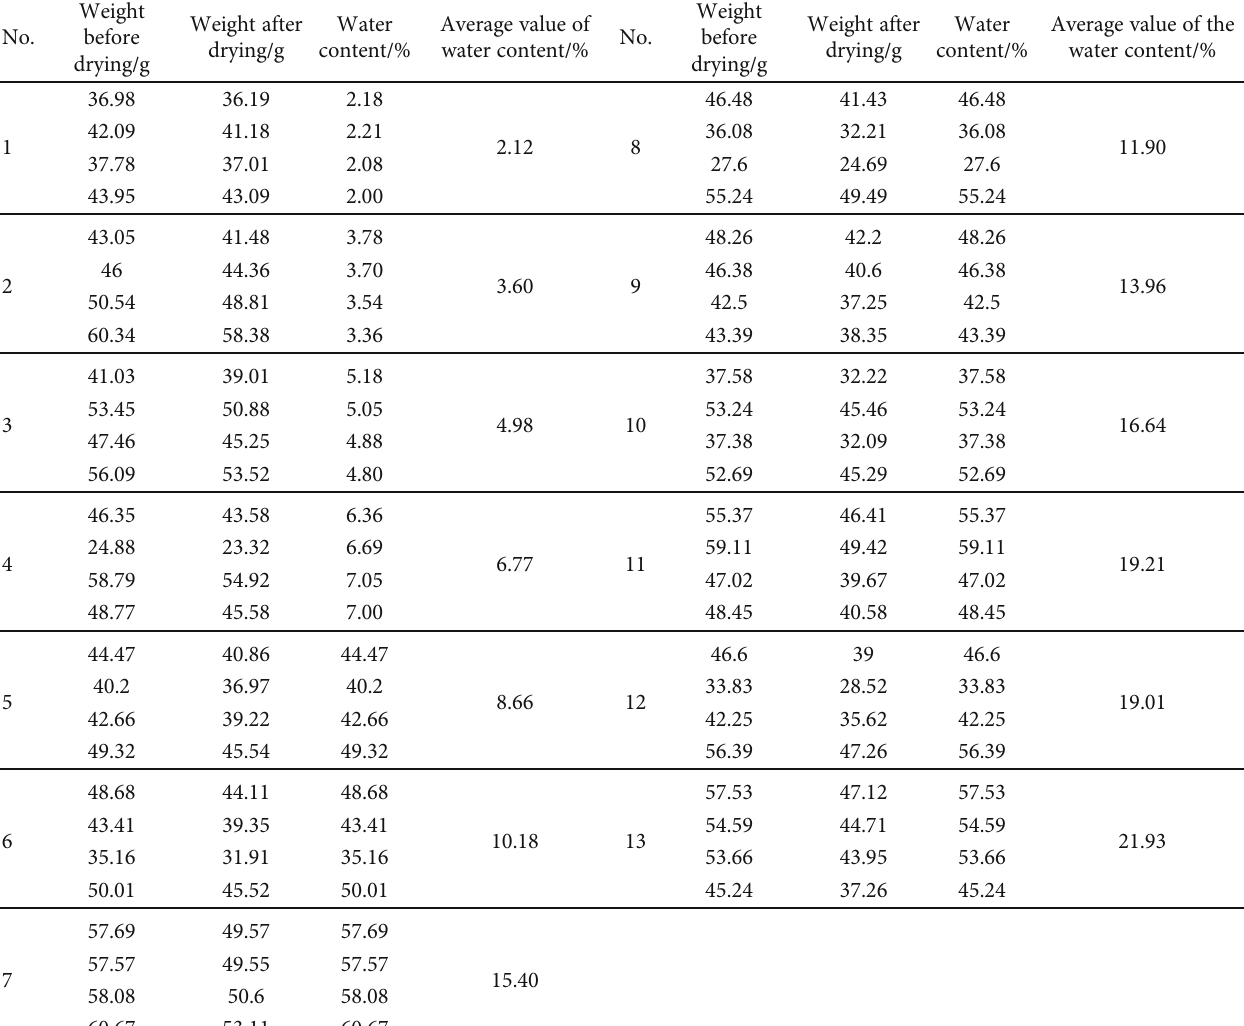
Table 1: Determination result of the water content.